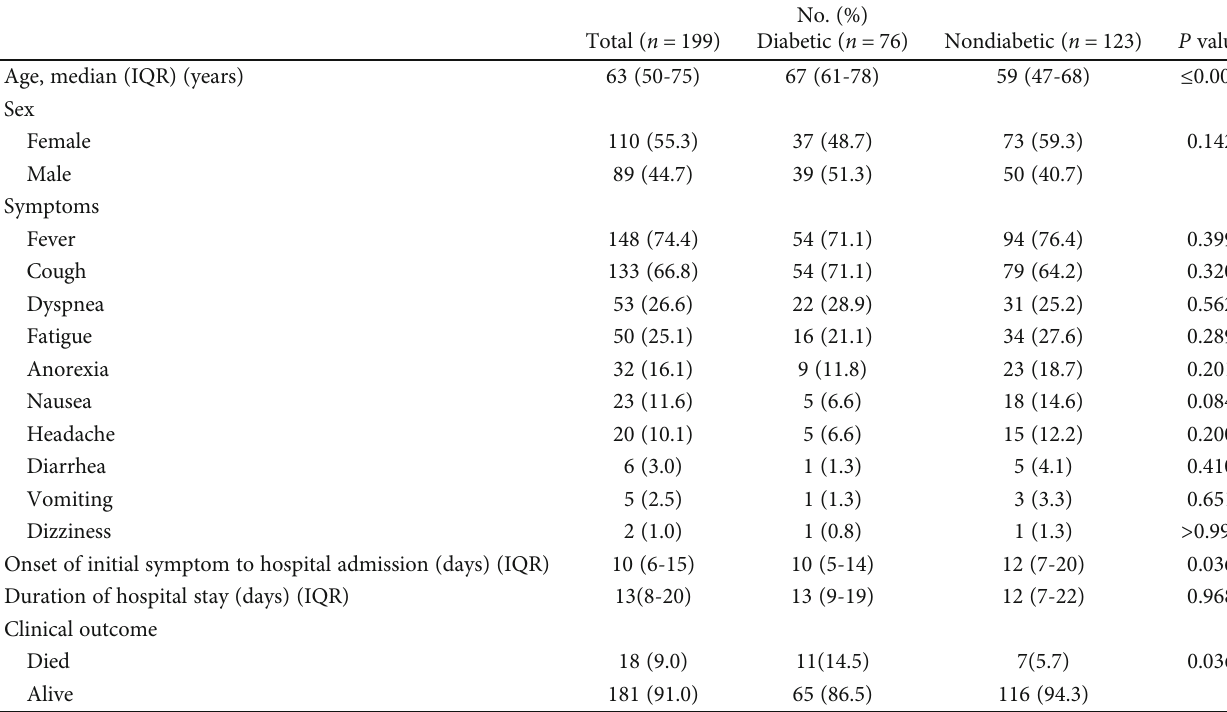
Table 1: Baseline characteristics of patients with COVID-19 pneumonia admission to the hospital.